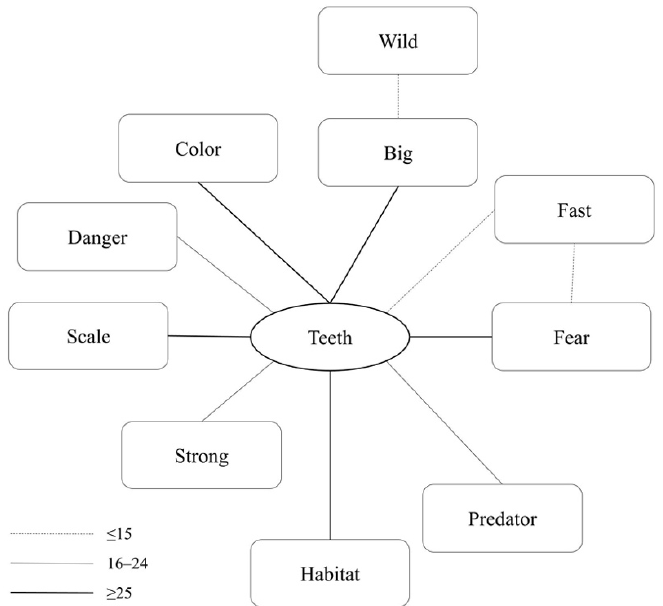
Figure 4. Tree with the elements of the social representation of crocodile (total sample).